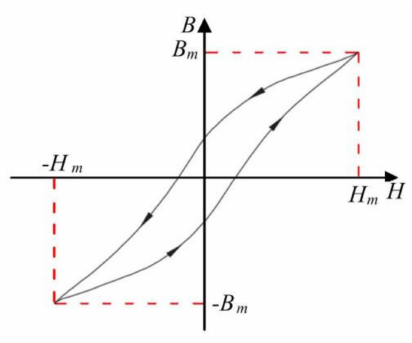
Figure 6. A diagram of the hysteresis effect.